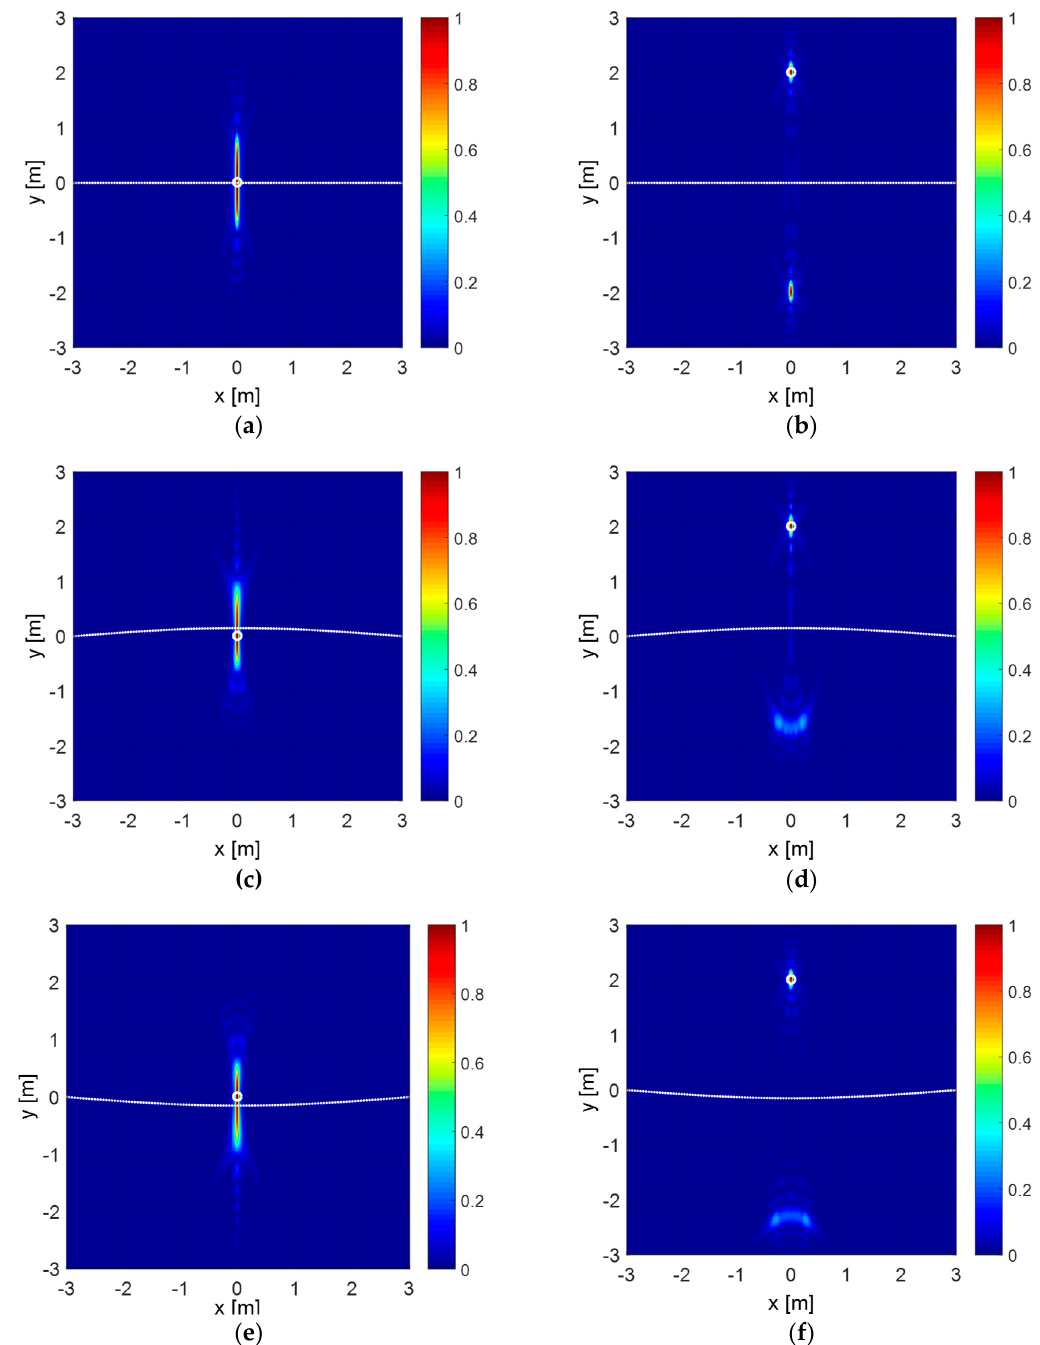
Figure 7. Point spread function (PSF) amplitude for a flight altitude ℎ = 5 𝑚 : ideal rectilinear trajectory and point like target with offset: ( a ) 𝑑 = 0 m, ( b ) 𝑑 = 2 m. Curved trajectory as described by Equation (13) and point-like target located with offset: ( c , e ) 𝑑 = 0 m, ( d , f ) 𝑑 = 2 m. The white dashed line represents the trajectory and the white circle denotes the target.